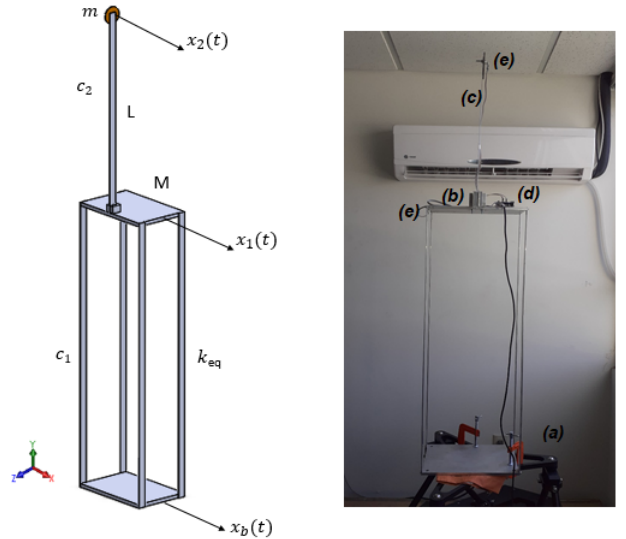
Figure 1. Illustration of the overall system (left side). View of the experimental setup (right side): ( a ) Hexapod Quanser, ( b ) primary system, ( c ) flexible vibration absorber, ( d ) microcontroller, ( e ) ac-